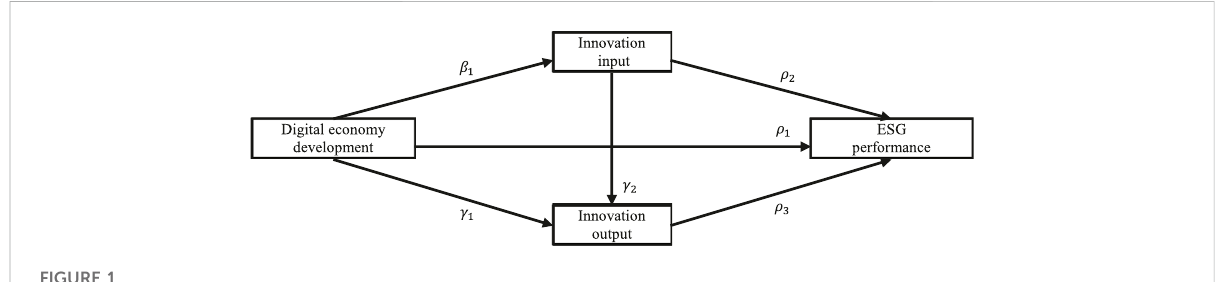
FIGURE 1 How does digital economy development affect enterprise ESG performance through innovation input and